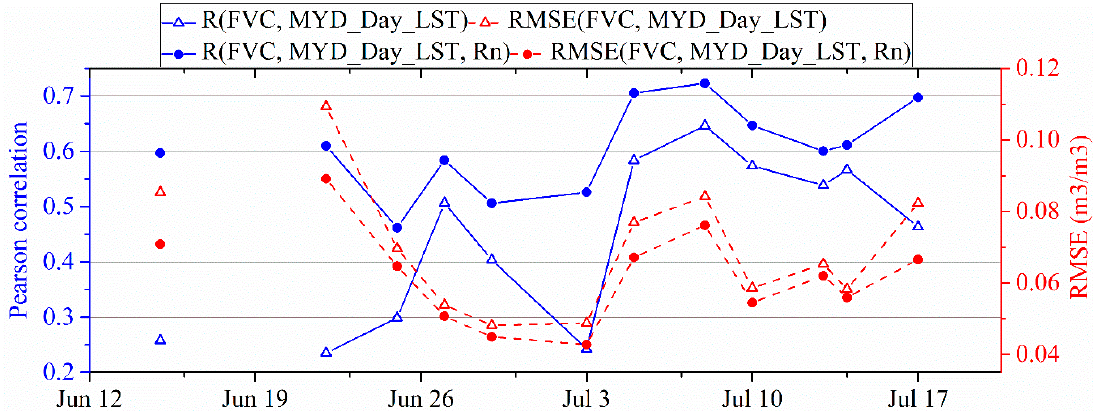
Figure 13. Pearson correlation coefficient (R) and RMSE between PALS SM and simulated SM that is generated by FVC and MOD_Day_LST (FVC, MOD_Day_LST) or FVC, MYD_Day_LST, and R n (FVC, MYD_Day_LST, R n ).